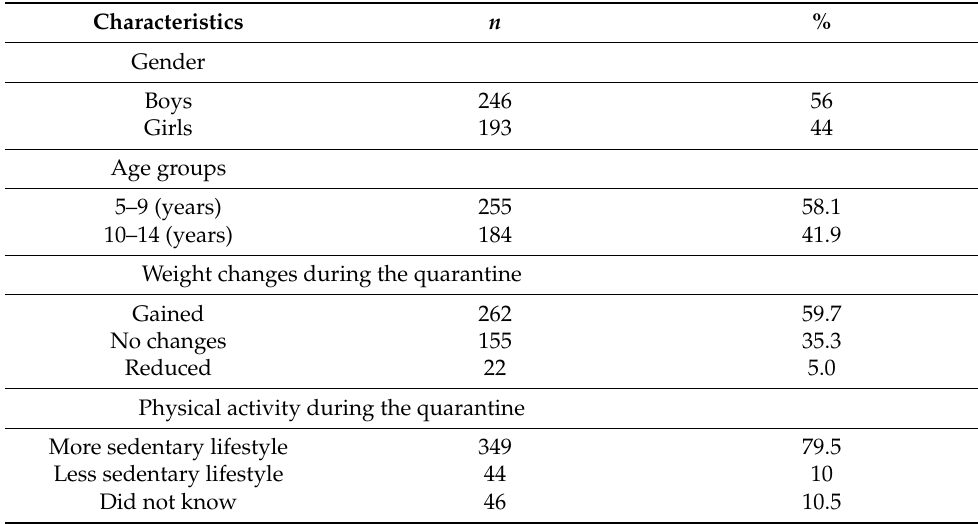
Table 1. Demographic and anthropometric characteristics and lifestyle habit changes of children and adolescents during the first COVID-19